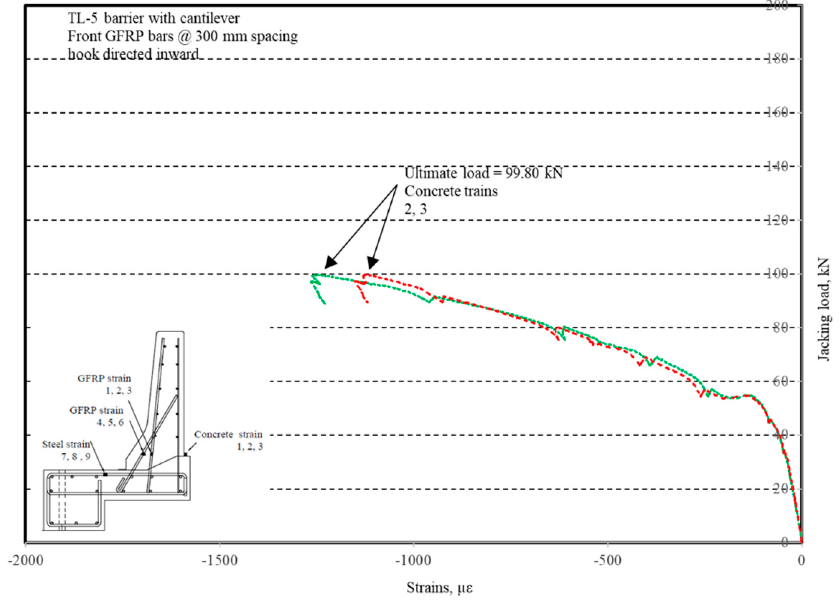
Figure 12. Specimen # 1: Load vs. bar strain history.